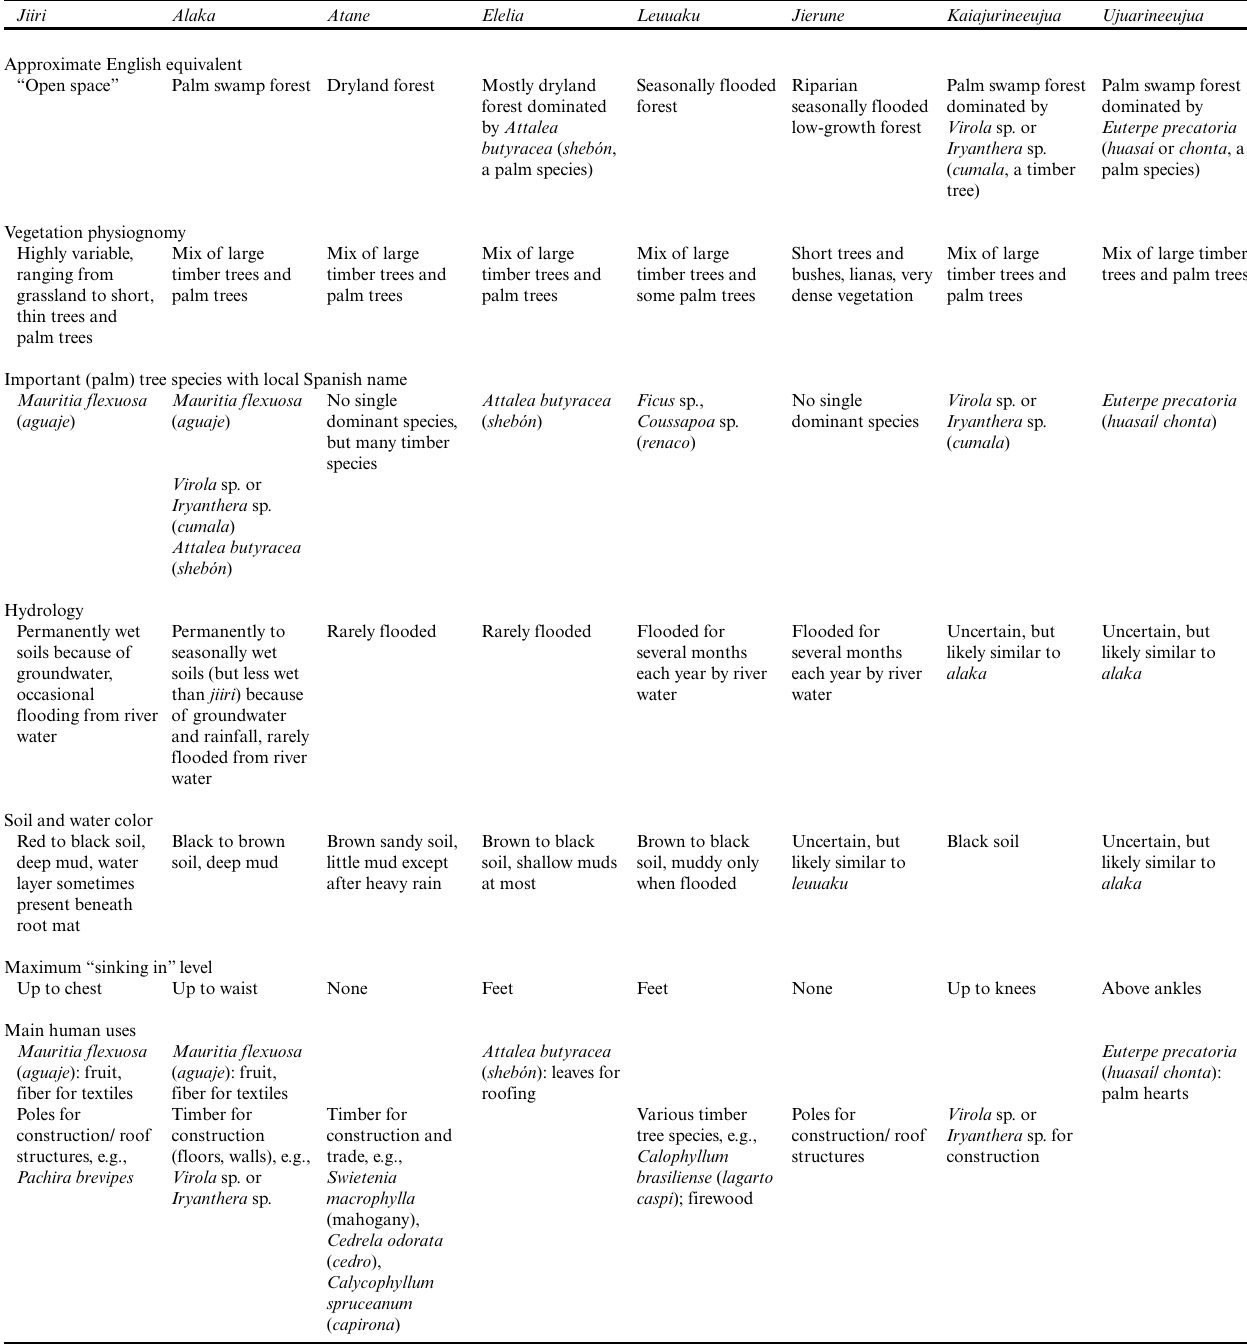
Table 2 . Summary of the characteristics of ecosystem types identified by Urarina interviewees. Where flooding is indicated, this was described as flooding by rivers. “Mud,” fango or barro in local Spanish and itanicha in Urarina, is taken to indicate soft substrates that may include peats and wet clayey and silty soils. Possible equivalent terms from the scientific literature on Peruvian wetland vegetation are tentatively indicated, as are the probable equivalent land-cover classes from Draper et al. (2014), although no formal attempt was made in the field to test their strict